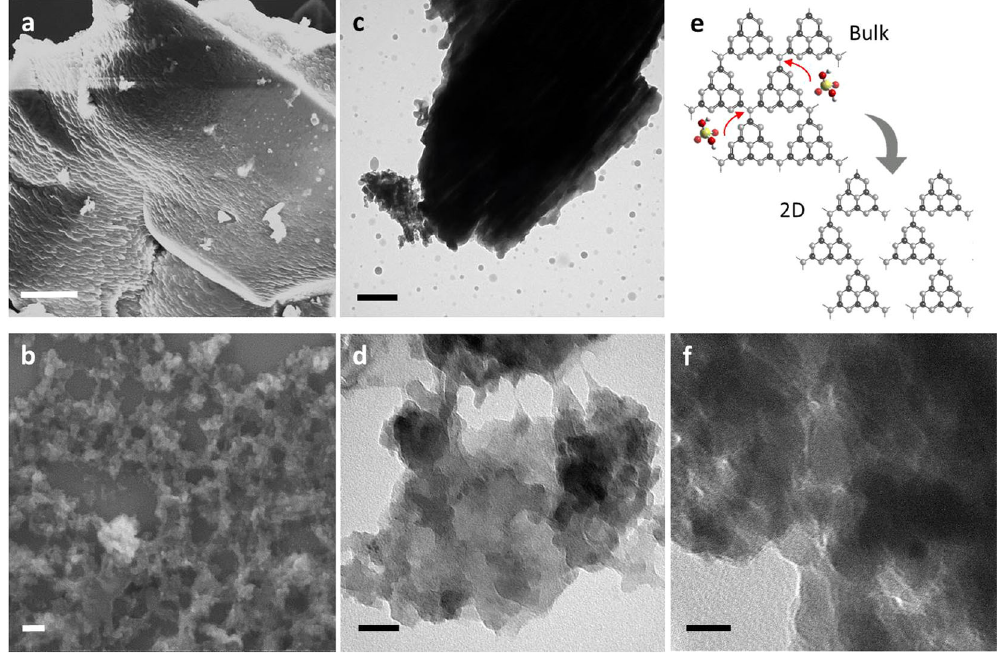
Fig. 1 Morphological characterization of GCN-based materials. a , b Representative SEM and, c , d , f TEM images of the bulk GCN ( a , c ), 2D GCN ( b , d ), and Cu-GCN(20) ( f ); and e scheme of the hydrolization process during the H 2 SO 4 treatment. Scale bars: a 2 µm, b 200 nm, c 500 nm, d 50 nm, f 20